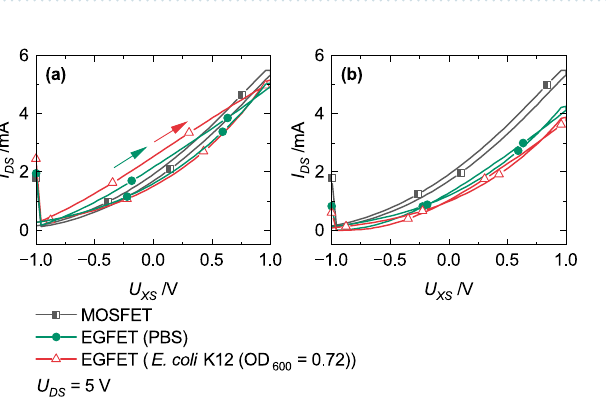
Figure 7. Transfer characteristics of EGFETs with R FG = 10 MΩ ( a , circles), R FG = 10 GΩ ( b , triangles), and R FG = 50 GΩ ( c , diamonds) contacted with a bacteria suspension each in comparison to only the transducer (squares).